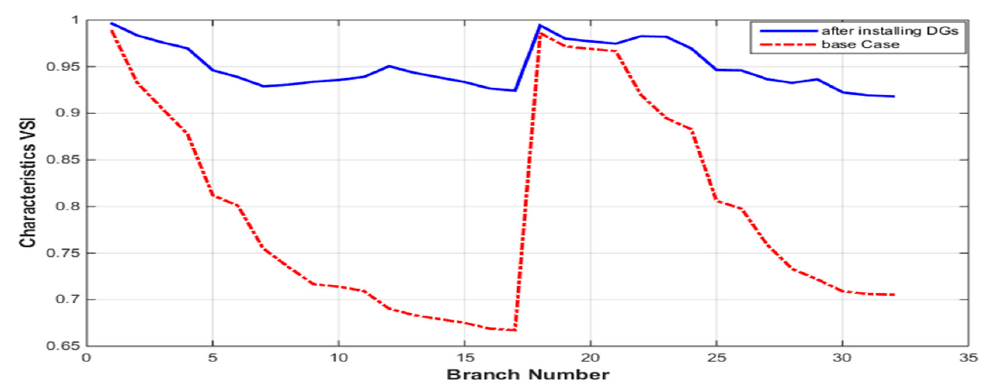
Figure 13. Characteristics of VSI, 33-bus system at 0.95 pf.